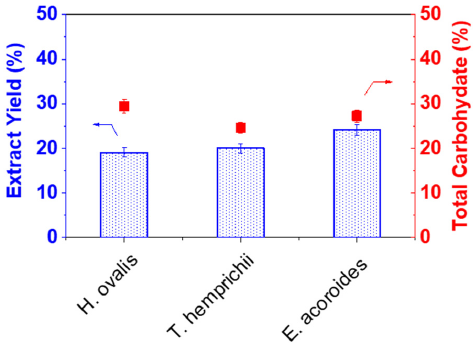
Figure 1. Yield (bar, left axis) and total carbohydrate content (red solid square, right axis) of pectin isolated from Vietnamese seagrass species.